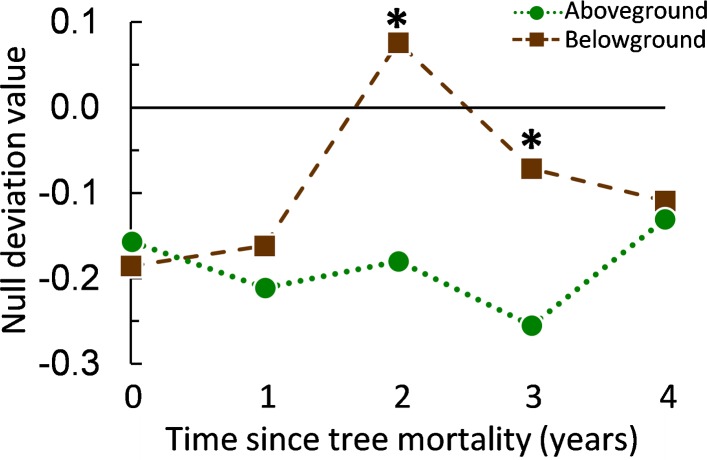
Null deviation values from aboveground and belowground arthropod communities sampled along a five-year chronosequence of insect-induced tree mortality.Null deviation values close to zero indicate species compositions that deviate less from random suggesting a greater relative influence of stochastic processes on community assembly, larger values (negative or positive) indicate increasing deviation from random and suggest greater relative influence of deterministic processes. Null deviation values of above- and belowground communities significantly differ within chronosequence years 2 and 3 as indicated by an asterisk (*) above the higher symbol.